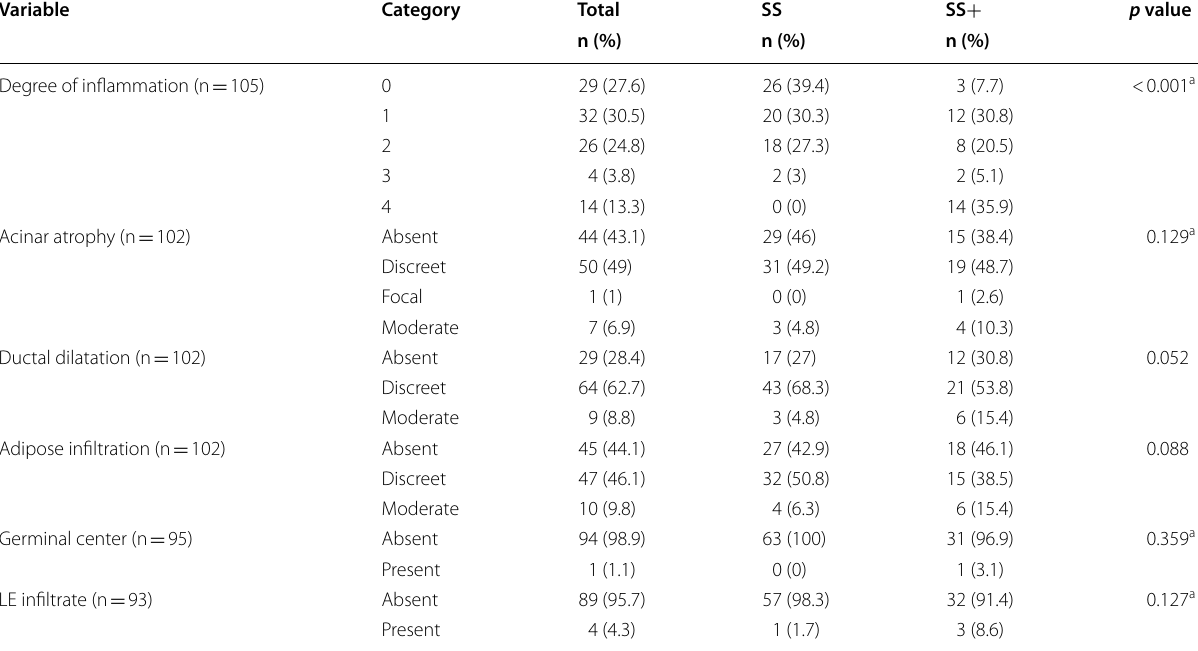
) and without SS (SS ) + −